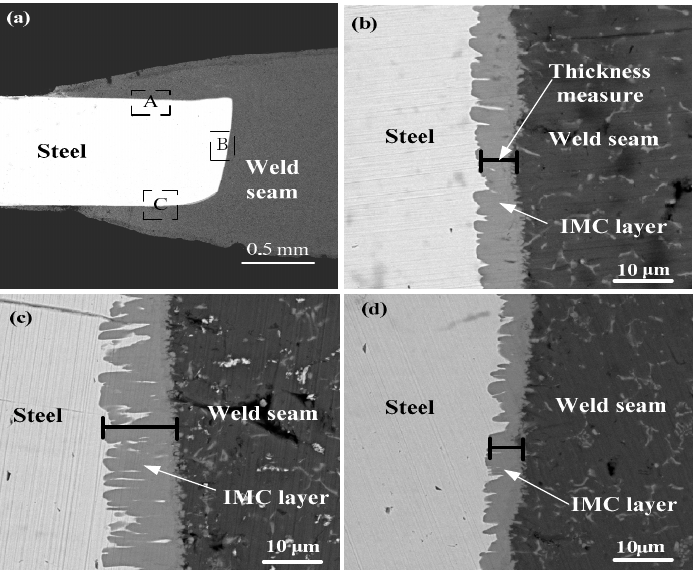
Figure 7. SEM images of the intermetallic compounds IMC layers at different locations of the Al-steel joint; ( a ) overview of the joint, ( b ) the IMC layer around the spot A, ( c ) the IMC layer around the spot B, and ( d ) the IMC layer around the spot C.